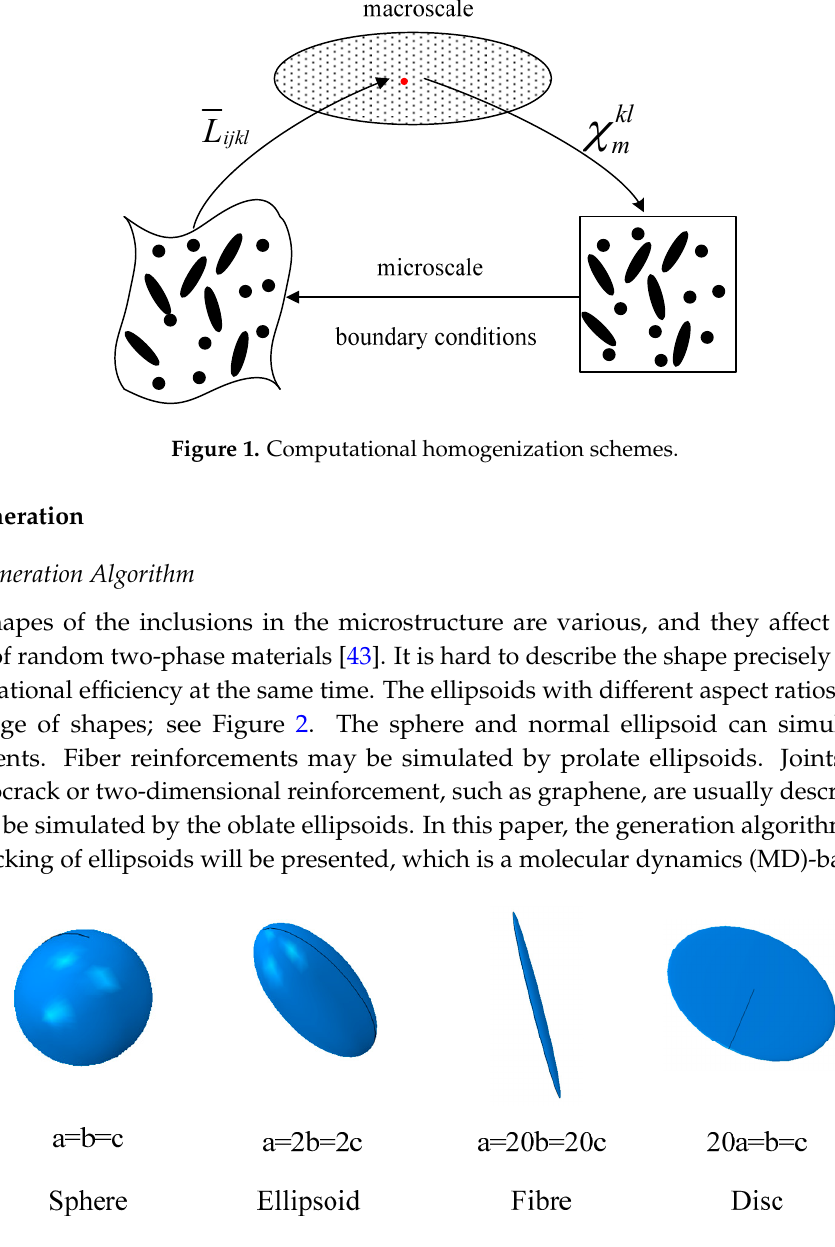
Figure 2. Ellipsoids with different aspect ratios.